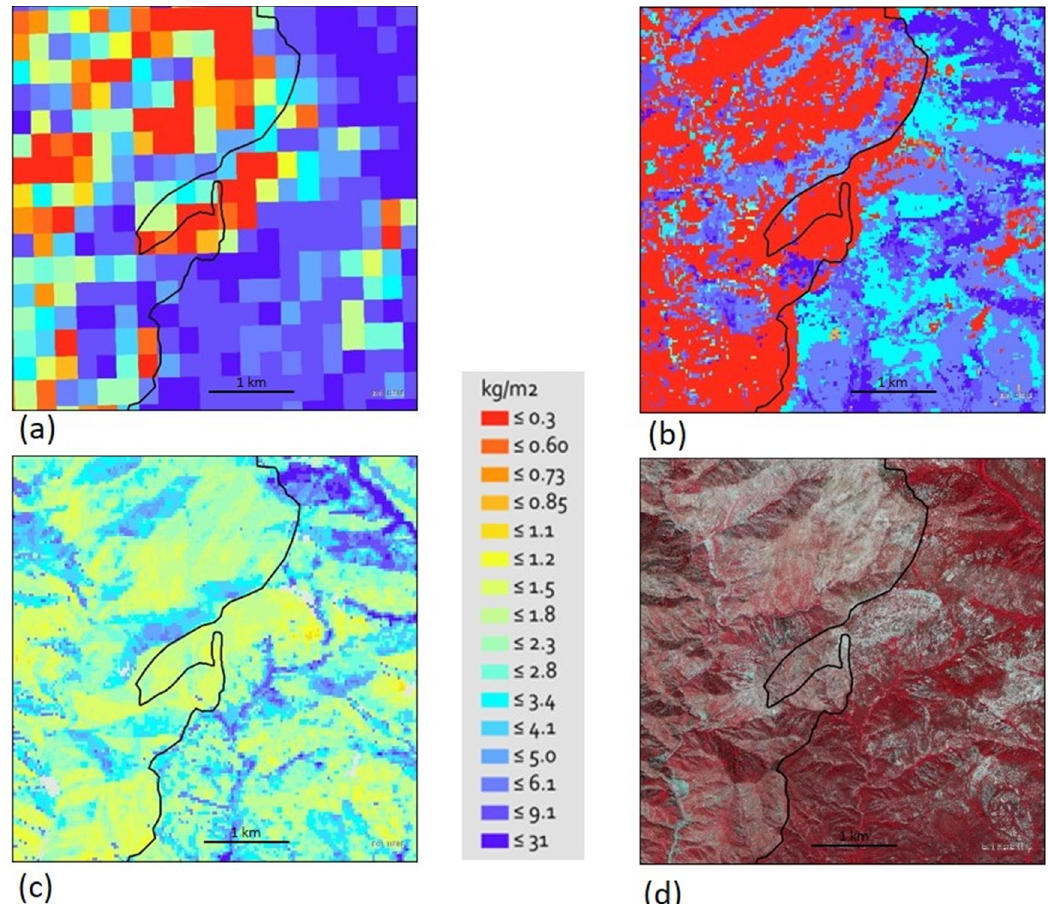
Figure 4. Subset images of the AGLBM estimates (2010) for a location on the Angeles NF approximately 35 km north of Los Angeles. The center coordinates of the image are − 117.950, 34.269 decimal degrees. The area to the left (west) of the black boundary line is within the Station fire (2009). The images are AGLBM estimates from ( a ) the University of Wisconsin-Madison (GHCD) at 300 m resolution [60], ( b ) California Air Resources Board (ARB) at 30 m resolution [61], and ( c ) the WETAC-UCD estimates from this study (30 m resolution). The 2012 false color infrared image from the USDA National Aerial Imagery Program is provided for reference ( d ).